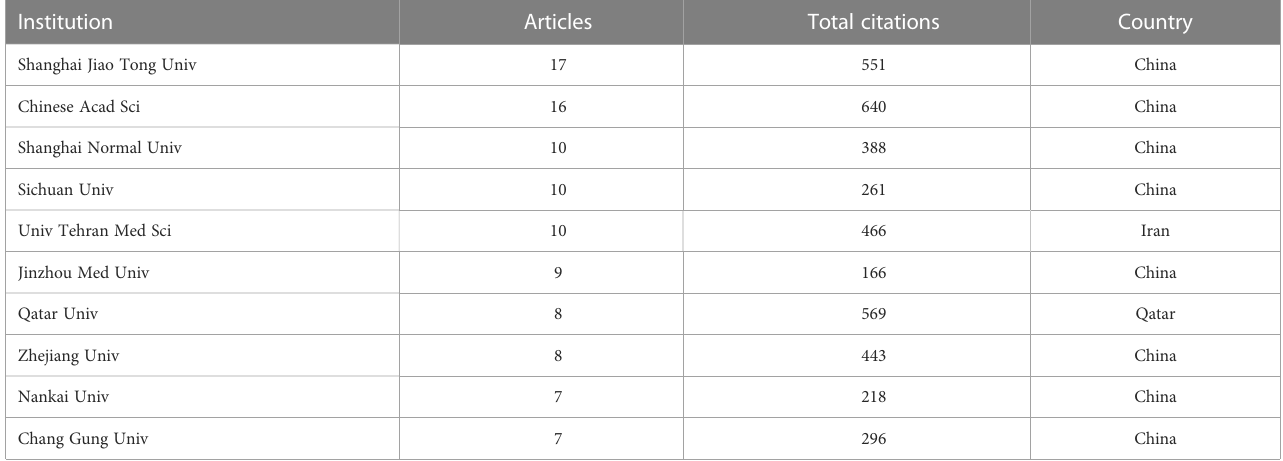
TABLE 2 The top 10 institutions in the fi eld of nanomaterials and diabetic wound healing.